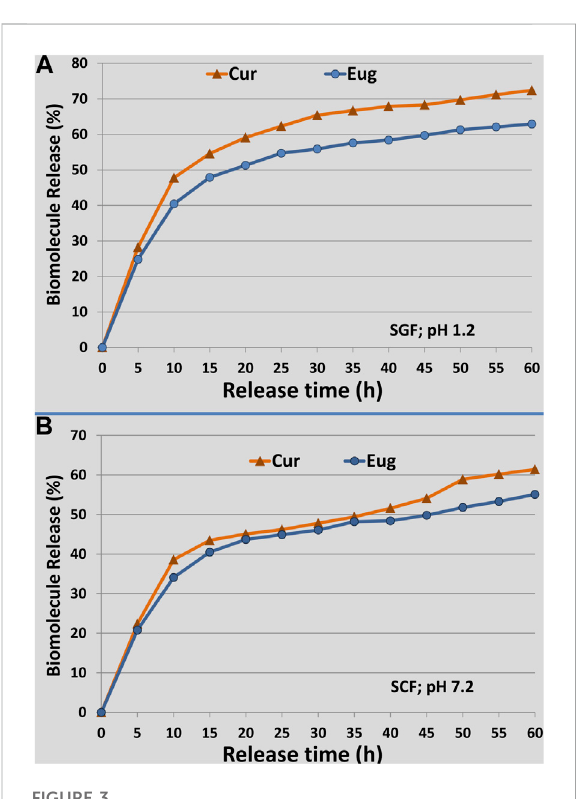
FIGURE 3 Release patterns of loaded curcumin (Cur) and eugenol (Eug) into chitosan nanoparticles under simulated conditions of